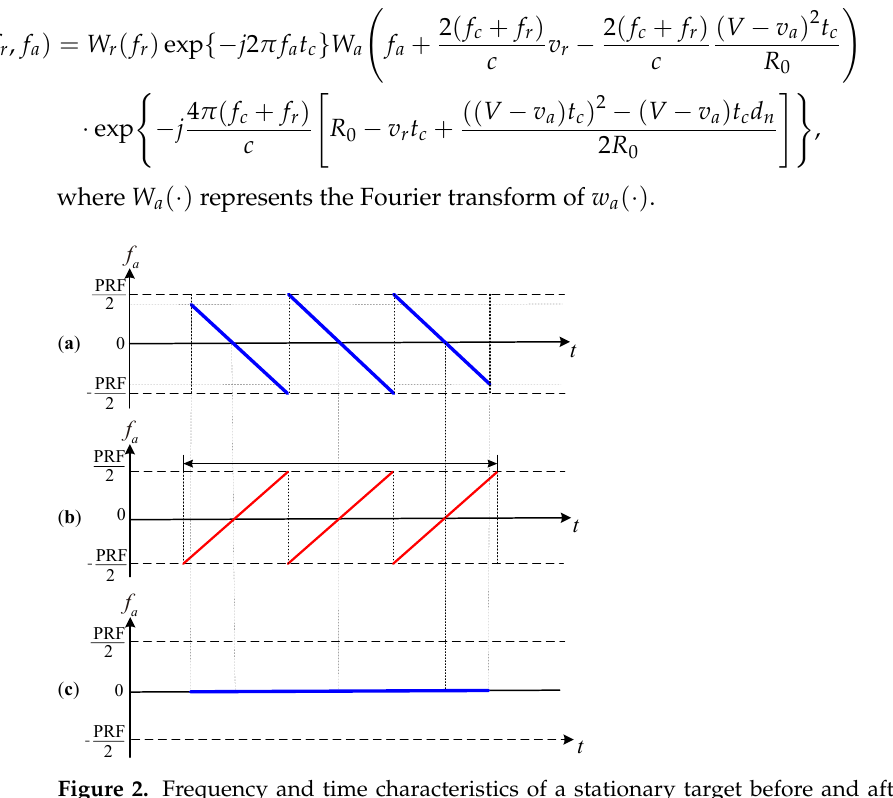
Figure 2. Frequency and time characteristics of a stationary target before and after the deramp processing in a multichannel HRWS SAR system, ( a ) the signals before the deramping, ( b ) the deramp function for the HRWS SAR, ( c ) the monochromatic signal after the